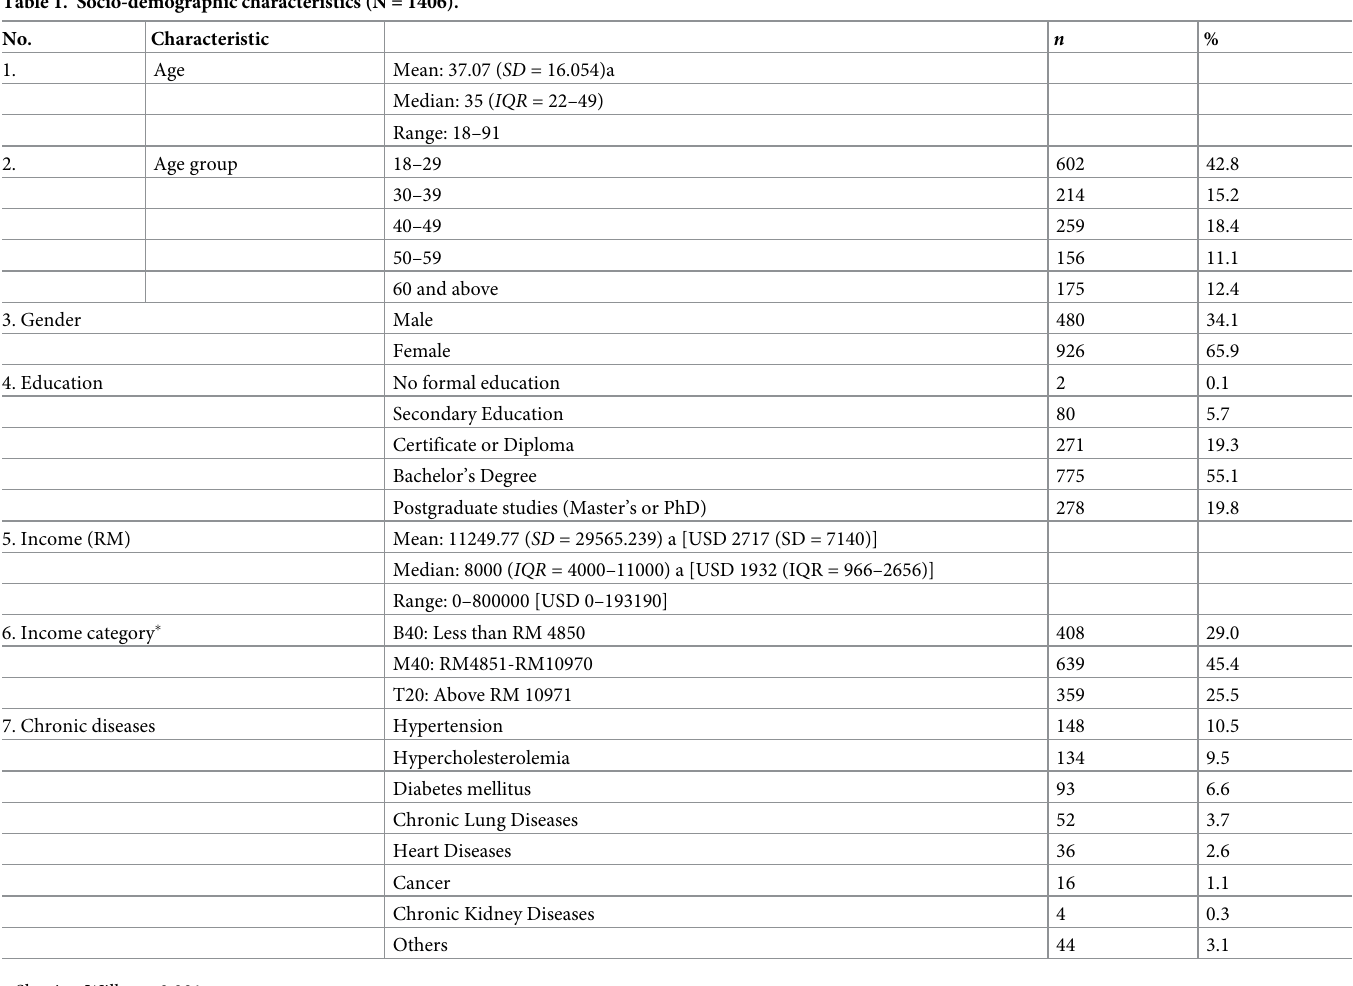
Table 1. Socio-demographic characteristics (N =